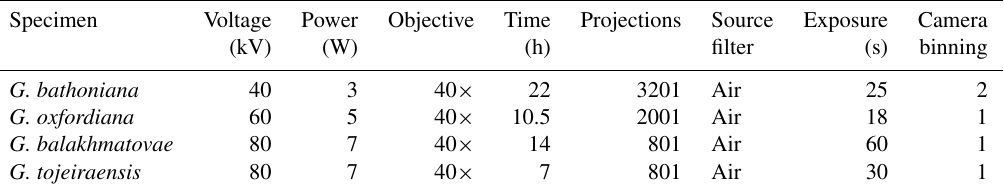
Table 1. CT-scan specifications used by specimen. Multiple scans were taken with Xradia as high-quality scans take a long time, so prelimi- nary scans were done